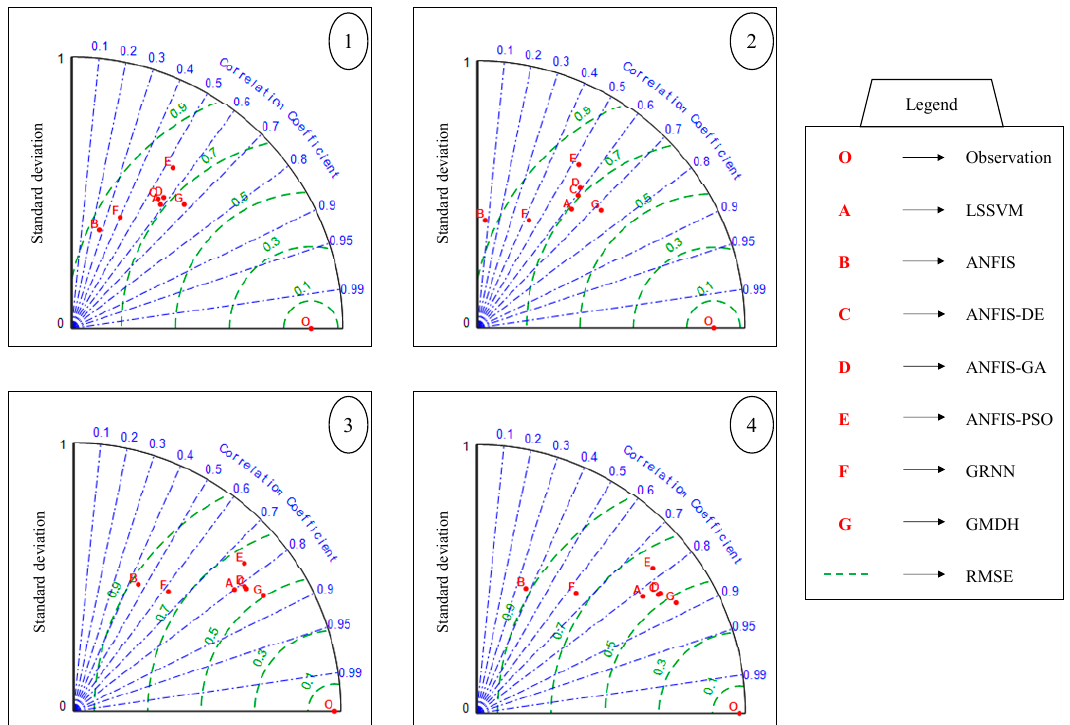
Figure 6. Taylor diagrams of the model prediction; Total evaluation of JDI’s predictions by inputs of gamma test (1) and entropy theory (2) and total evaluation of MSPI’s predictions by inputs of gamma test (3) and entropy theory (4).